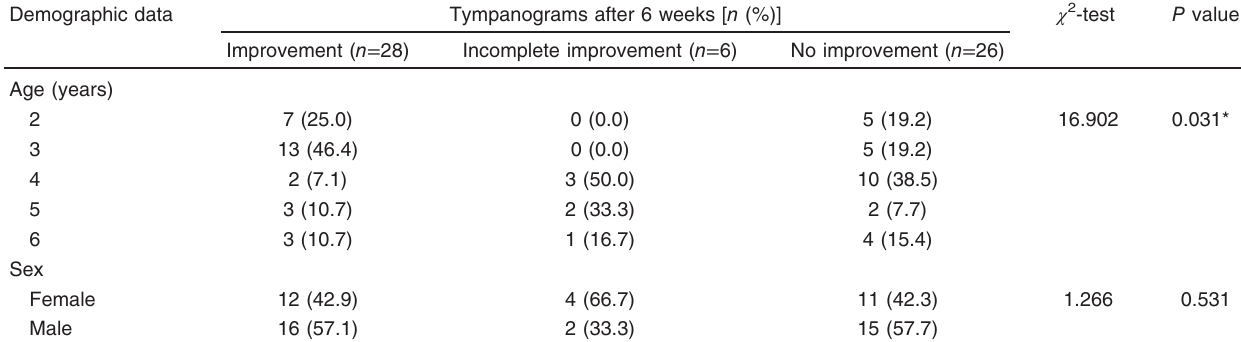
Table 11 Relation between tympanograms after 6 weeks and demographic data in all patients Demographic